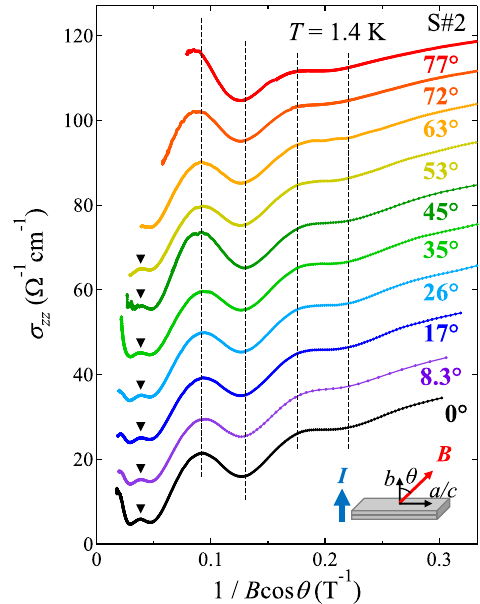
Fig. 4 Angular dependence of quantum oscillation. The σ zz data measured at various fi eld tilt angles ( θ ) are plotted versus 1 = B cos θ , where θ is the angle between the b -axis and the fi eld (inset). Each curve at θ ≥ 8.3 ∘ is shifted vertically (by 10 Ω − 1 cm − 1 ) The vertical dashed lines denote the positions of the σ zz peaks and dips arising from the SdH oscillation. The triangles denote the positions of the additional peak structure at high fi